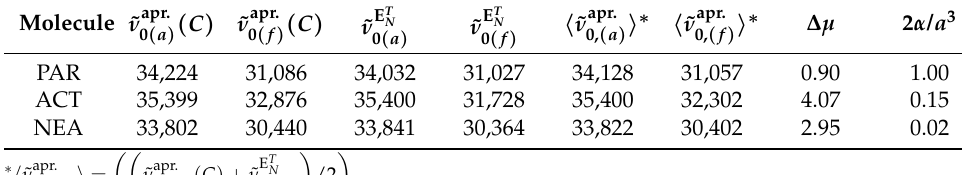
Table 4. Transition energies in the gas phase obtained on the basis of ( i ) Catalàn model for aprotic (apr.) systems and average of two alternatively determined values (cid:104) ˜ ν apr. values obtained using multiple linear regression